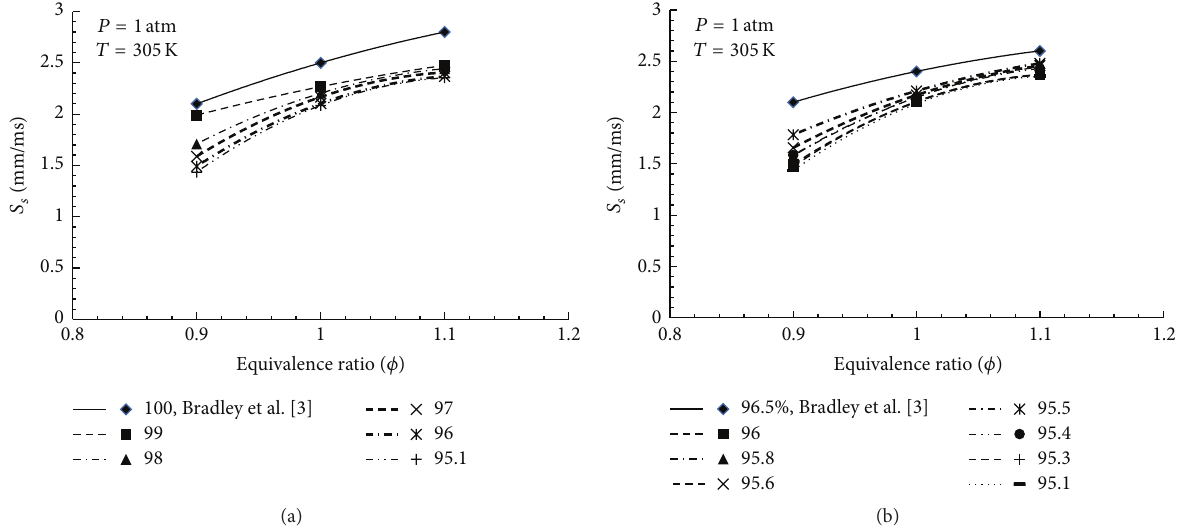
Figure 11: (a) Unstretched flame velocity of ethanol in various water content versus equivalence ratio. (b) Unstretched flame velocity of hydrous ethanol versus equivalence